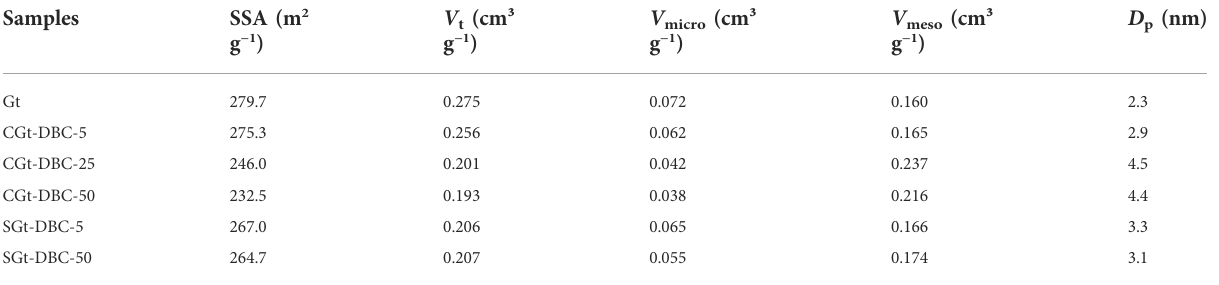
TABLE 1 Speci fi c surface area and pore structure of Gt and Gt-DBC samples.